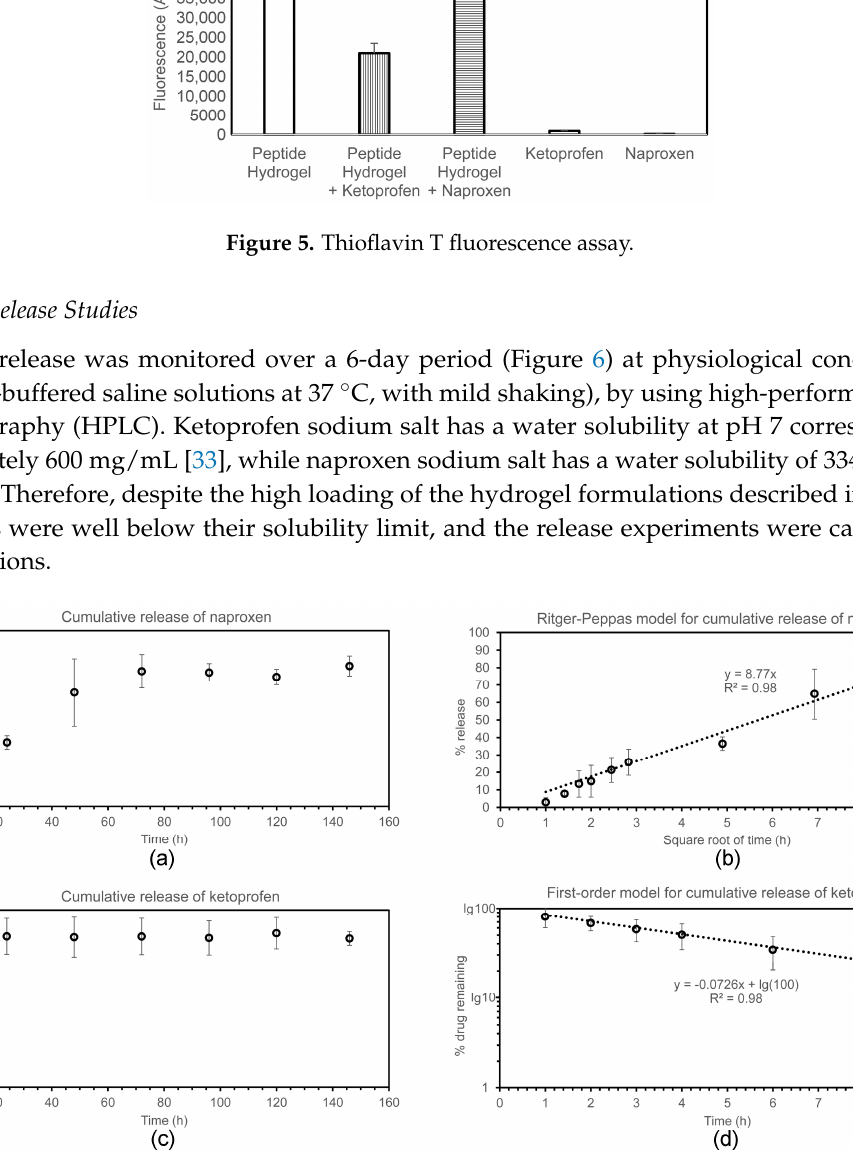
Figure 6. Drug release study for naproxen ( a , b ) and ketoprofen ( c , d ).